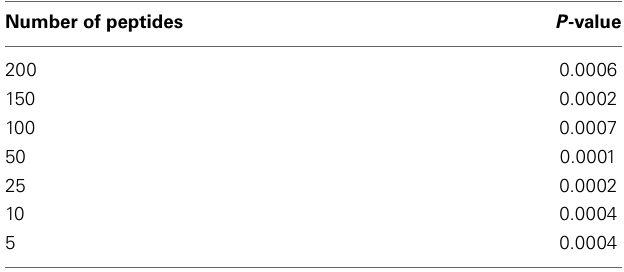
Table 1 | Ability of subsets of peptides to discriminate susceptible and resistant bees at the dark-eyed pupae stage.